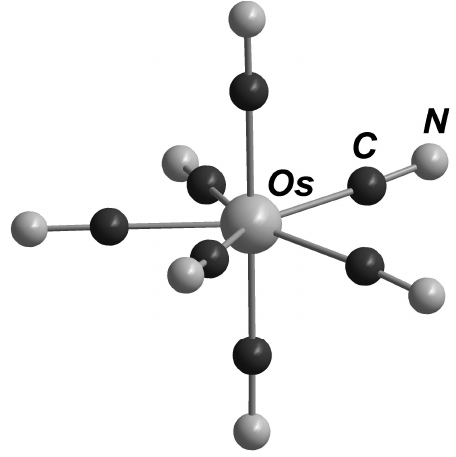
Figure 1. Structure of pentagonal bipyramidal [Os(CN) 7 ] 3 − complex in 1 .